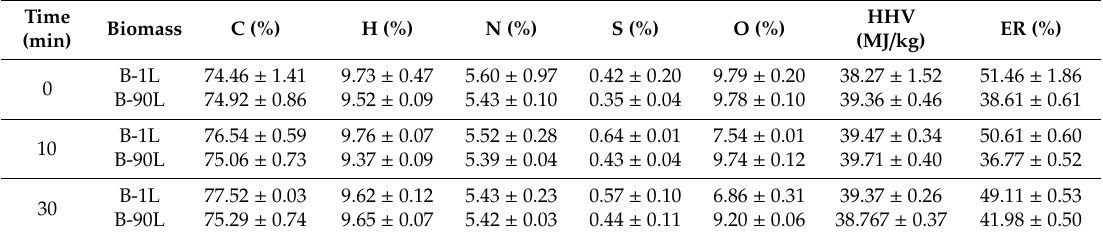
Table 9. Elemental analysis (wt%, dry basis), higher heating value (HHV) and energy recovery of the biocrude phase after the hydrothermal liquefaction (HTL) process at 320 ◦ C for di ff erent reaction times. B-1L and B-90L: P. tricornutum biomass cultivated in 1 L and 90 L bioreactors, respectively. ER: energy